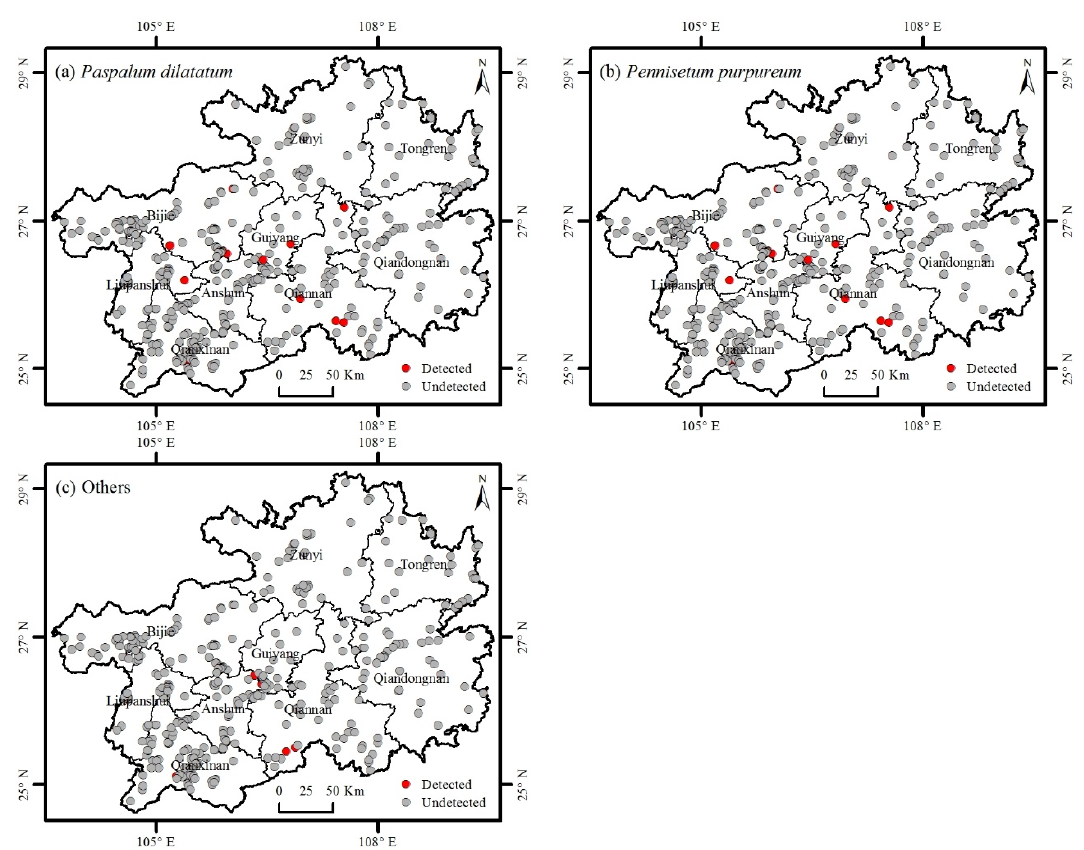
Figure 4. Distribution of locally invasive plants (Level 3). Red and grey dots indicate detected and undetected invasive species,